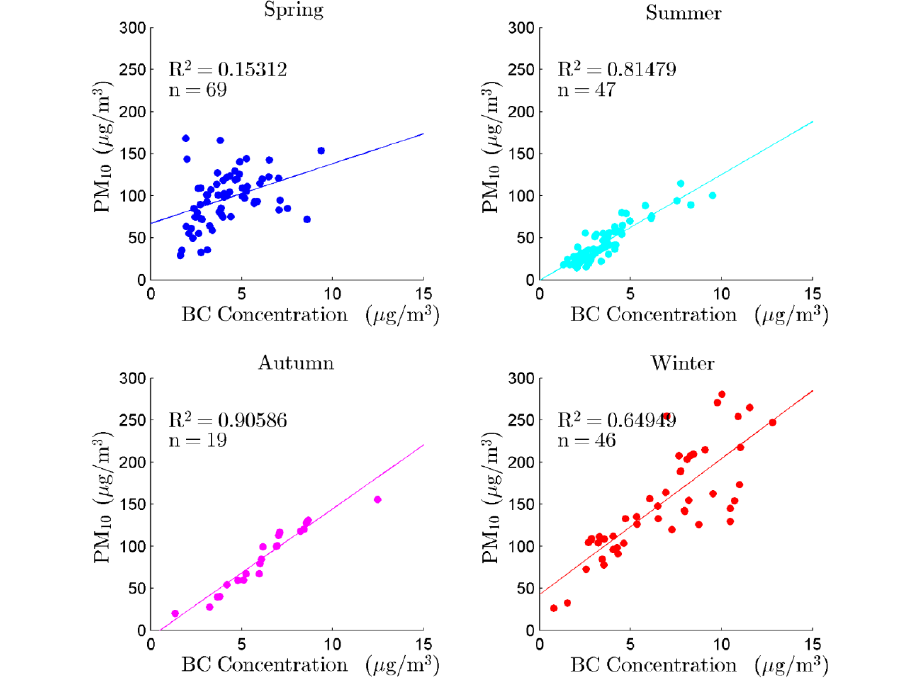
Figure 6. Correlation between the mass concentrations of PM 10 and black carbon